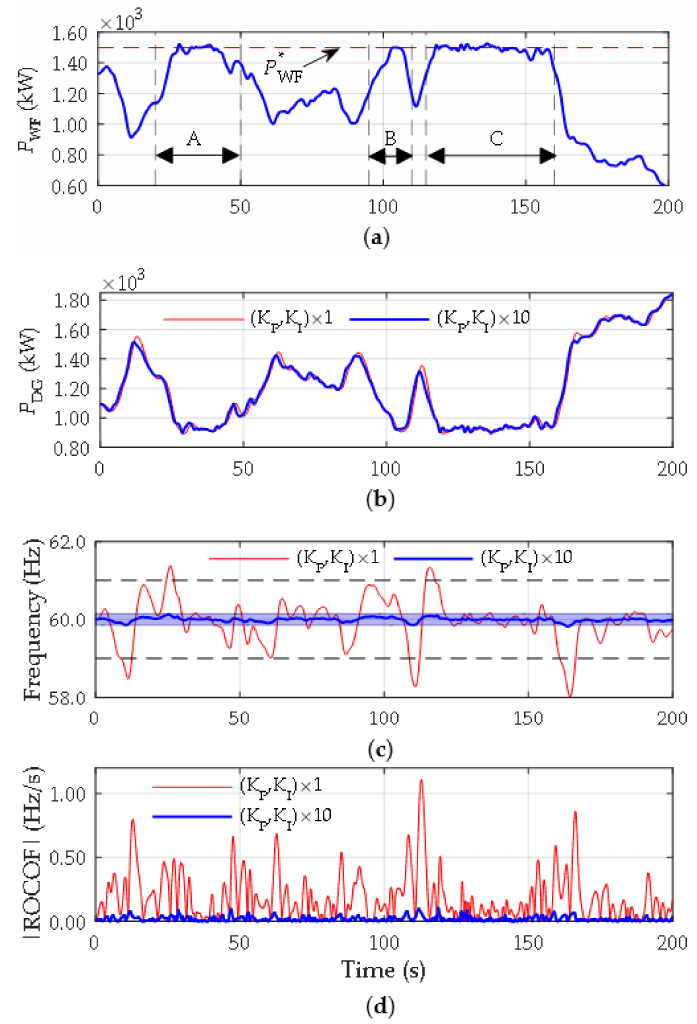
Figure 15. Adjustment of the control gains of the diesel-engine speed governor and its effect on the power system dynamics: ( a ) Wind farm generated power; ( b ) Diesel power plant production; ( c ) Grid frequency and; ( d )